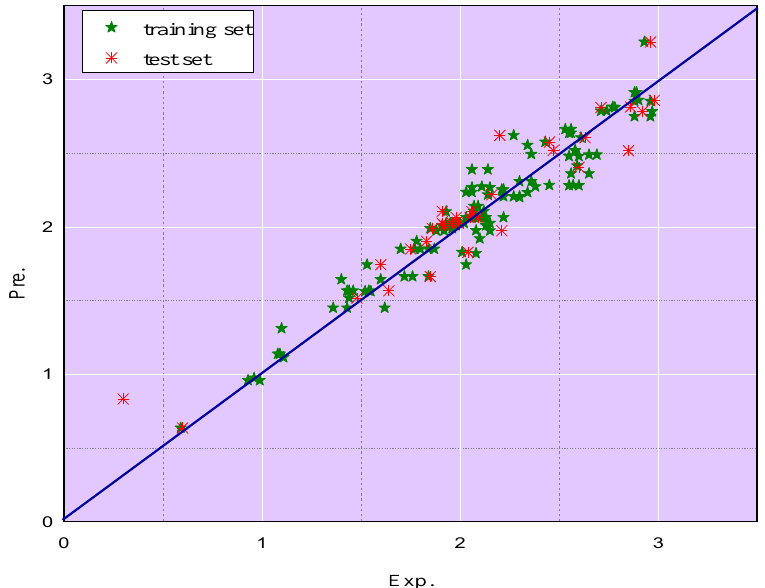
Figure 2. Comparisons of predicted the logEC 50 values of ILs towards acetyl cholinesterase enzyme (AChE) (logEC 50 (AChE)) by multiple linear regression (MLR) in external validation with the experimental logEC 50 (AChE).